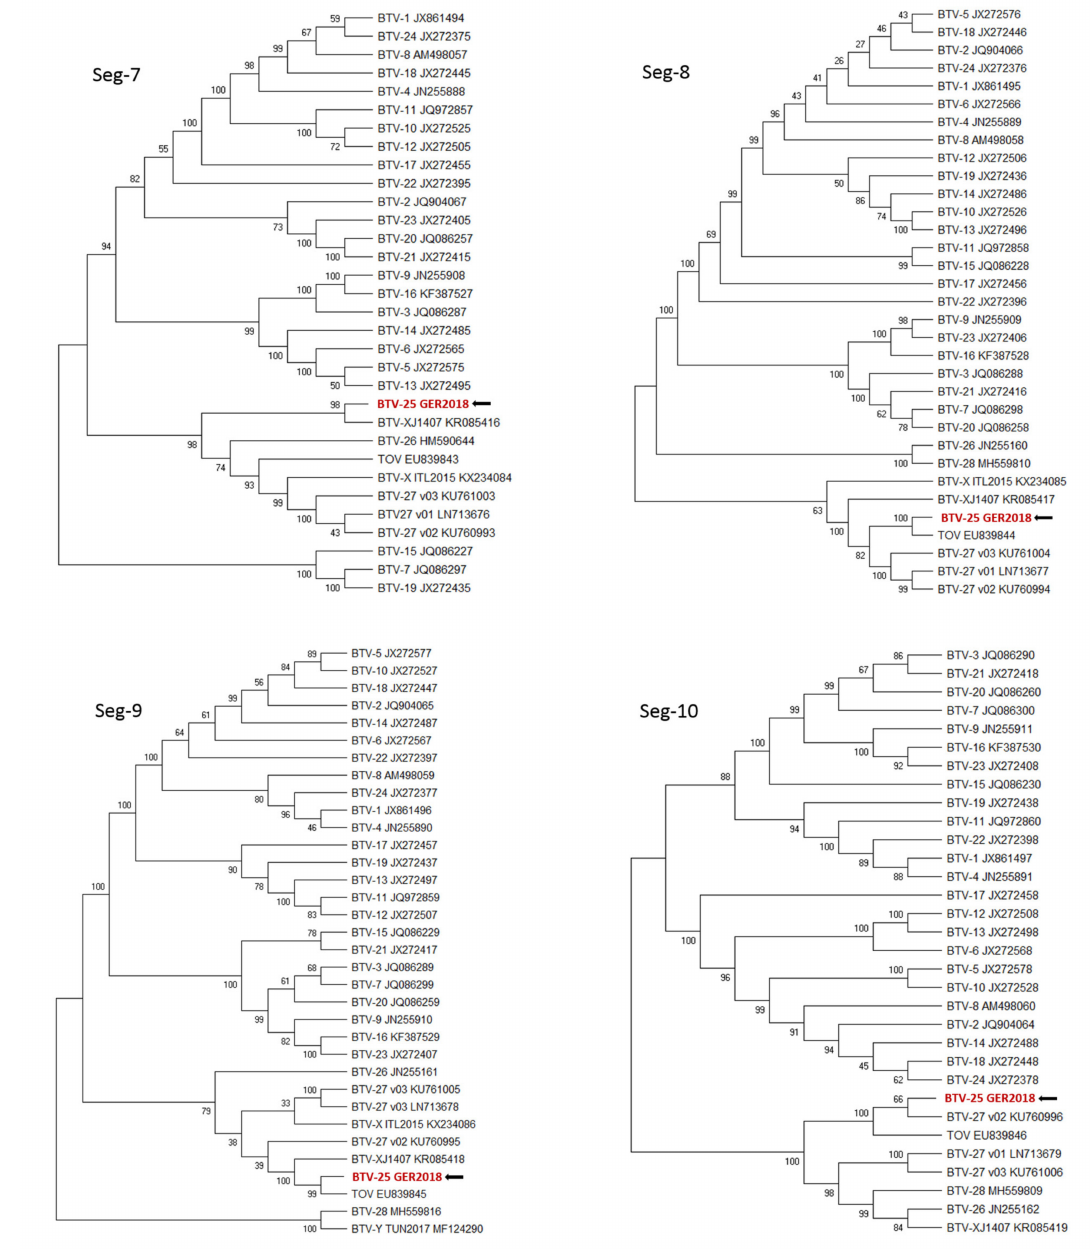
Figure 1. Phylogenetic analyses of the BTV-25-GER2018 genome. The phylogenetic trees of each of the 10 segments were created with MegaX using the genetic distinction model Tamura–Nei and tree-built method UPGMA including BTV strains representing the known BTV serotypes published [6]. We performed a bootstrap analysis with 1000 replications. The colors of the phylogenetic trees of segment 2 (Seg-2) and segment 6 (Seg-6) represent the di ff erent nucleotype groups [32] and trees were modified with FigTrees. For easier identification of the di ff erent nucleotypes A-N, the unrooted tree layout was chosen for Seg-2 and Seg-6. The arrows point at the BTV-25-GER2018 sequence. The BLAST results of the nucleotide and amino acid sequences of the complete coding sequence of the BTV-25-GER2018 segments are shown in Table 1. The most related strains for all segments were found to be solitary representatives of atypical BTVs, which is consistent with the phylogenetic trees. The nearest neighbor (nt-based) for segment 1 was BTV-Z ITL2017 with 96.6%, and aa-based with 92.2% TOV. Segment 2 also matched with BTV-Z ITL2017 in nt and aa with 92.5% and